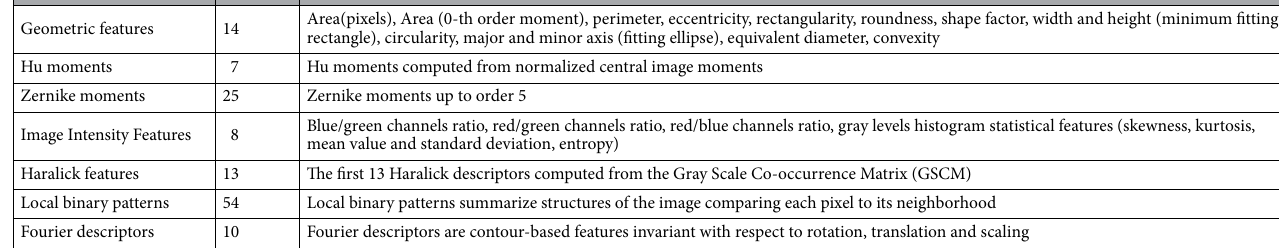
Table 1. List of morphological features extracted from the processed images. See Supporting Information for a detailed explanation.